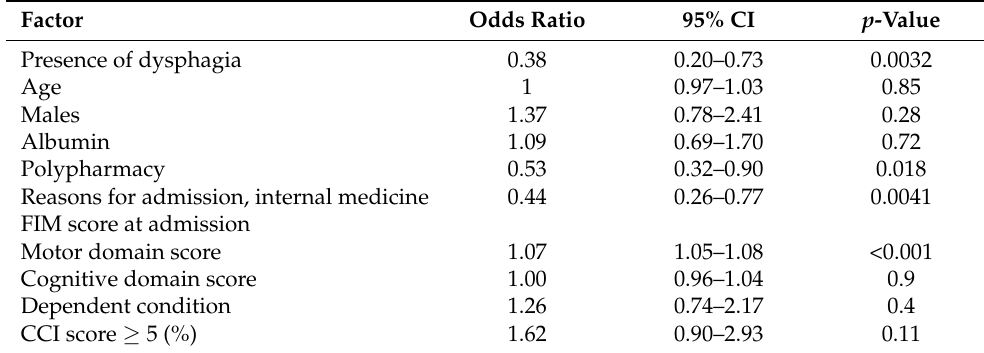
Table 5. Results of the multivariate logistic regression model regarding the relationship between dysphagia and home